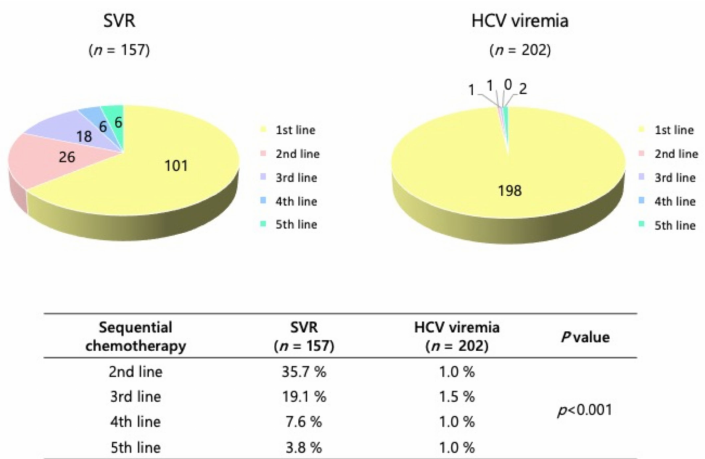
Figure 4. Sequential chemotherapies in HCV-related HCC patients treated with first-line molecular targeted therapies: SVR vs. HCV viremia. A total of 101, 56, 30, 12, and 6 patients received first-, second-, third-, fourth- and fifth-line chemotherapy in the SVR group, respectively. On the other hand, just 4 patients could receive second- or later-line treatment in the HCV viremia